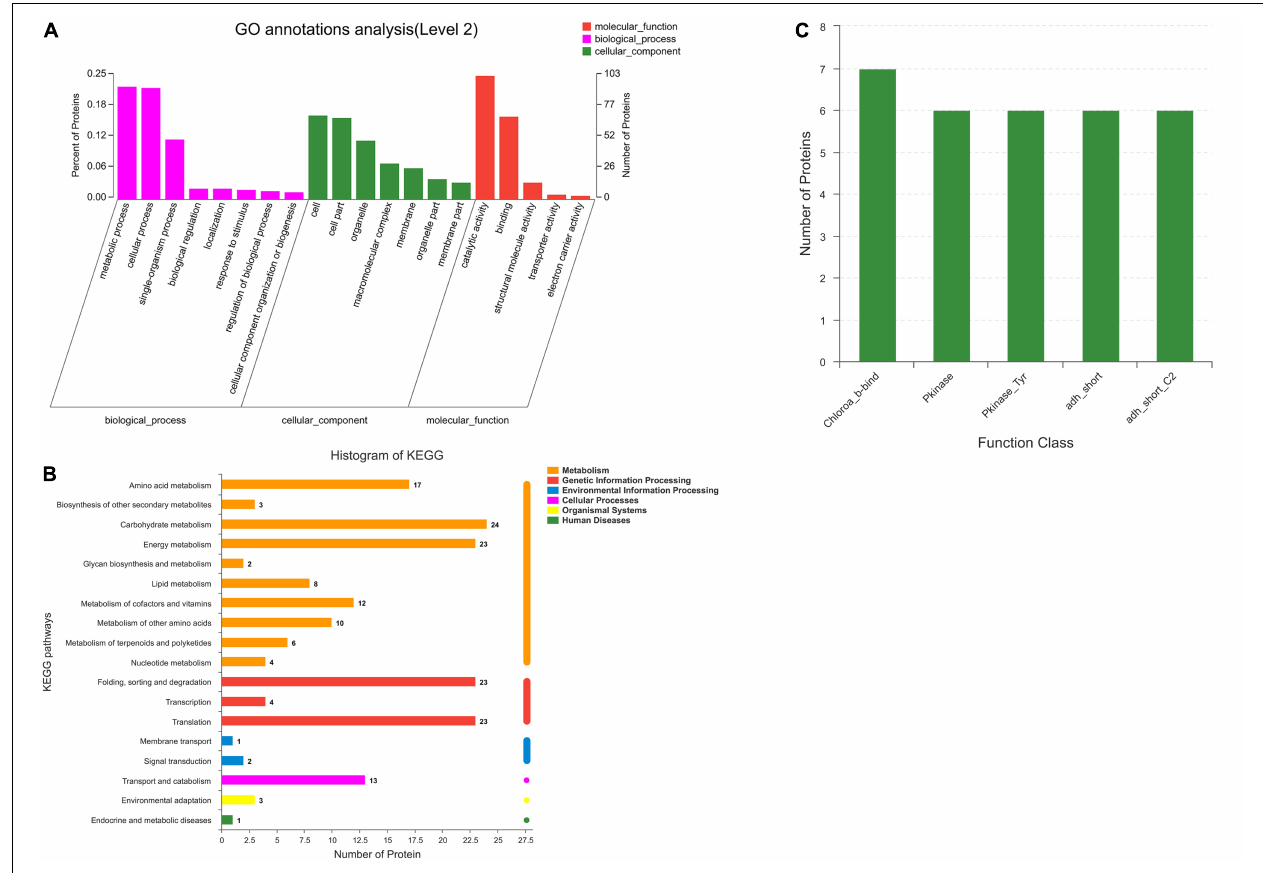
( Figure 3 ). Physical direct interactions are represented by continuous lines, while functional interactions are represented by discontinuous lines. In carbohydrate metabolism, have a protein indicated as N/A, no annotation information will be discussed temporarily.